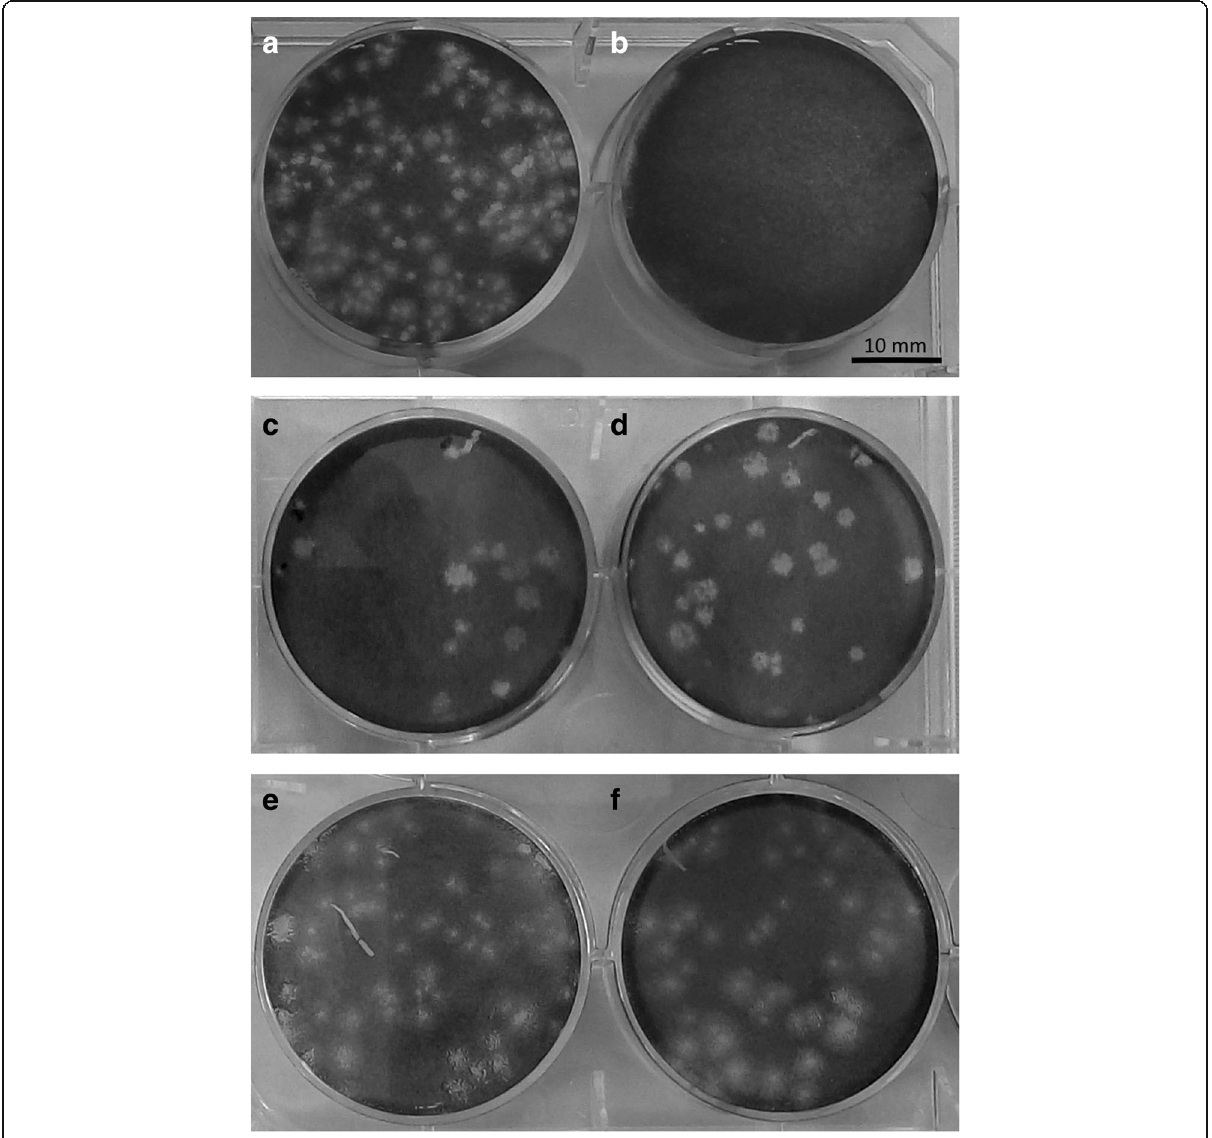
Fig. 2 Inhibiting the formation of lytic plaques using methanolic extracts at 60 °C. DENV infection in BHK21 cells were inhibited incubating the plant extracts with every extract before the infection assay. Effect of 200 μ g/ml of U. dioica ( c ), T. officinale ( d ), C. integrifolia ( e ) and C. pulcherrima ( f ) extracts are shown. Non-inhibited and non-infected controls are shown in a and b ,